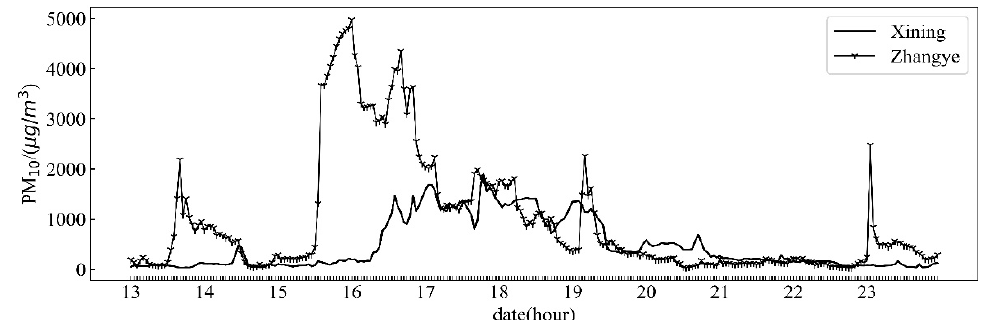
Figure 10. Hourly variation curves of surface PM 10 concentration in Xining and Zhangye cities from 13 to 23 March, 2021.